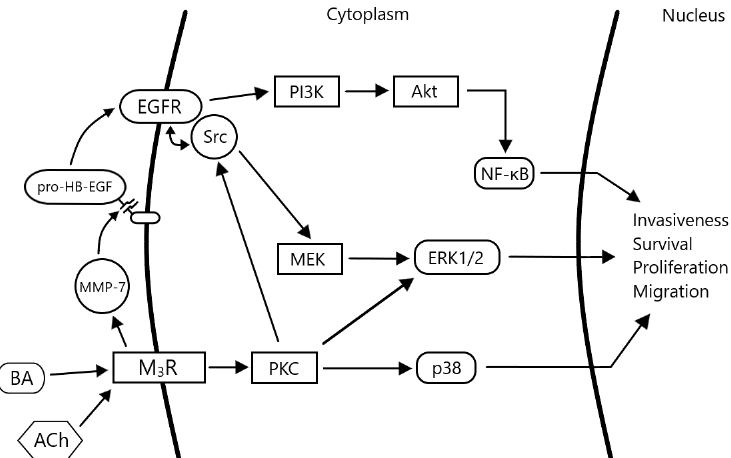
Figure 1. Complex signaling following activation of muscarinic receptors in colon cancer cells.